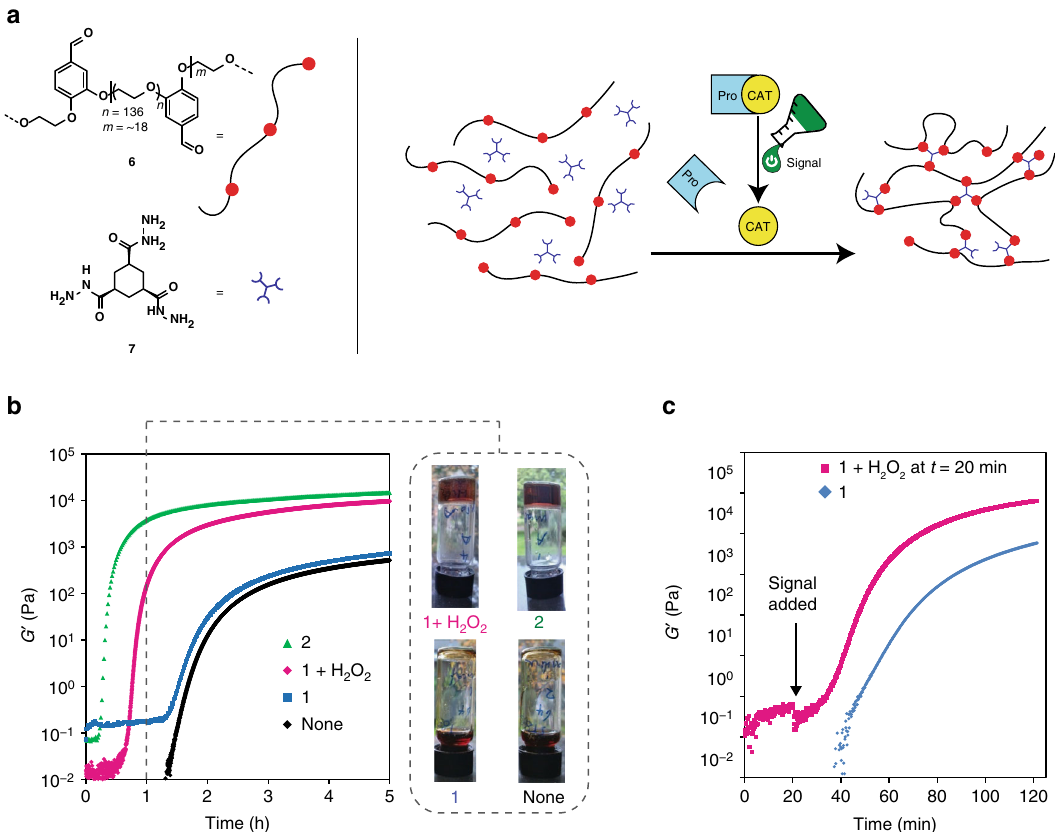
Fig. 3 Polymer gel formation controlled by the activation of pro-aniline 1 . a The formation of a hydrazone polymer gel: aldehyde 6 and hydrazide 7 react to form a crosslinked hydrazone polymer gel. b The storage modulus G ’ measured with oscillatory rheology during gel formation at 25 °C (10 mM hydrazide 7 , 136 mg ml − 1 aldehyde 6 in 20% dimethylformamide in 100 mM phosphate buffer, pH 6.0) for the uncatalyzed gel (black line), the gel with 10 mM pro- aniline 1 (blue line), the gel with 10 mM pro-aniline 1 and 10 equivalents H 2 O 2 (magenta line) and the gel with 10 mM aniline 2 (green line). The gelation rate with activated pro-aniline 1 is comparable to the gelation rate with aniline 2 . Without activation of the pro-aniline 1 , the gelation rate is comparable to the gelation rate of the uncatalyzed reaction. After 1 h of gelation time, the mixtures with aniline 2 or activated pro-aniline 1 have gelled, whereas the mixtures without catalyst or with unactivated pro-aniline 1 have not gelled yet. We performed the gelation experiment in vials using the same conditions as we used for rheology and took a photograph after 1 h of reaction time. Top left: pro-aniline 1 (10 mM) and H 2 O 2 (100 mM), top right: aniline 2 (10 mM), bottom left: pro-aniline 1 (10 mM) and bottom right: without catalyst. c The gelation rate can be controlled during the process by adding a chemical signal (here after 20 min), liberating the catalyst. The storage modulus G ’ measured with oscillatory rheology for the aldehyde 6 /hydrazide 7 (10 mM) mixture with 10 mM pro-aniline 1 (blue line) and the mixture with pro-aniline 1 when 10 equivalents of H 2 O 2 was added after 20 min (magenta line). Addition of the chemical signal induces a signi fi cant increase in gelation